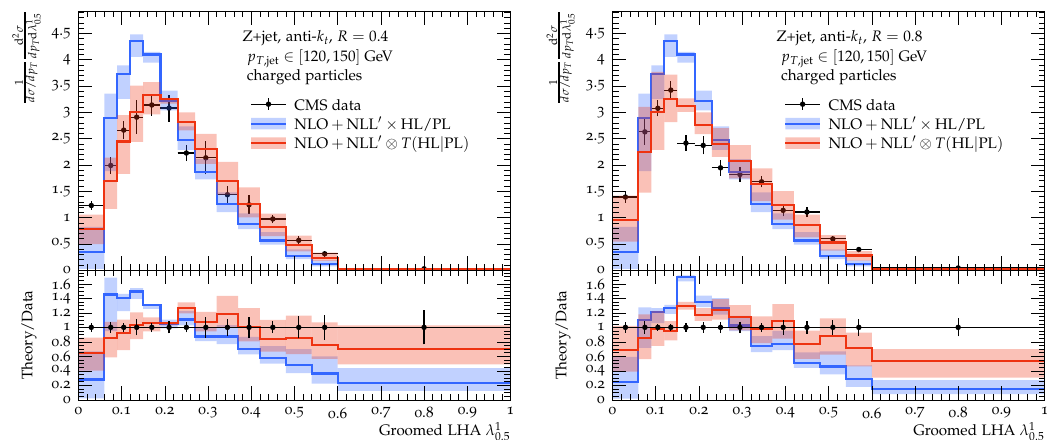
Figure 5. Hadron-level predictions for the groomed Les Houches Angularity λ 1 production, measured on the charged hadrons in R = 0 . 4 (left) and R = 0 . 8 (right) jets with p T, jet ∈ [120 , 150] GeV. Results are obtained based on the NLO + NLL 0 perturbative predictions including NP correction using the HL/PL ratio ( × HL / PL) and the new transfer-matrix approach ( ⊗ T ( HL | PL )